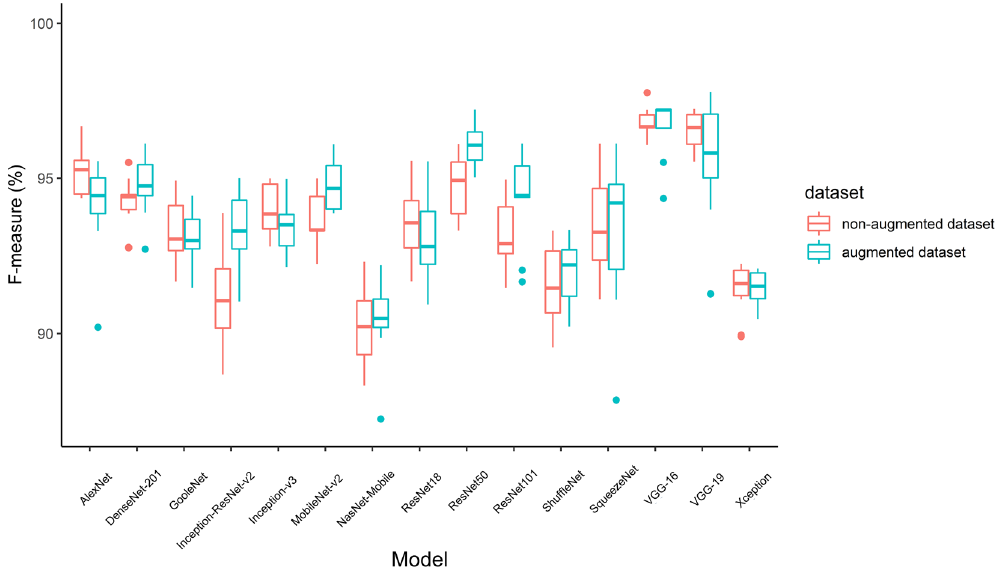
Figure 5. Test results for 10 folds of each deep learning